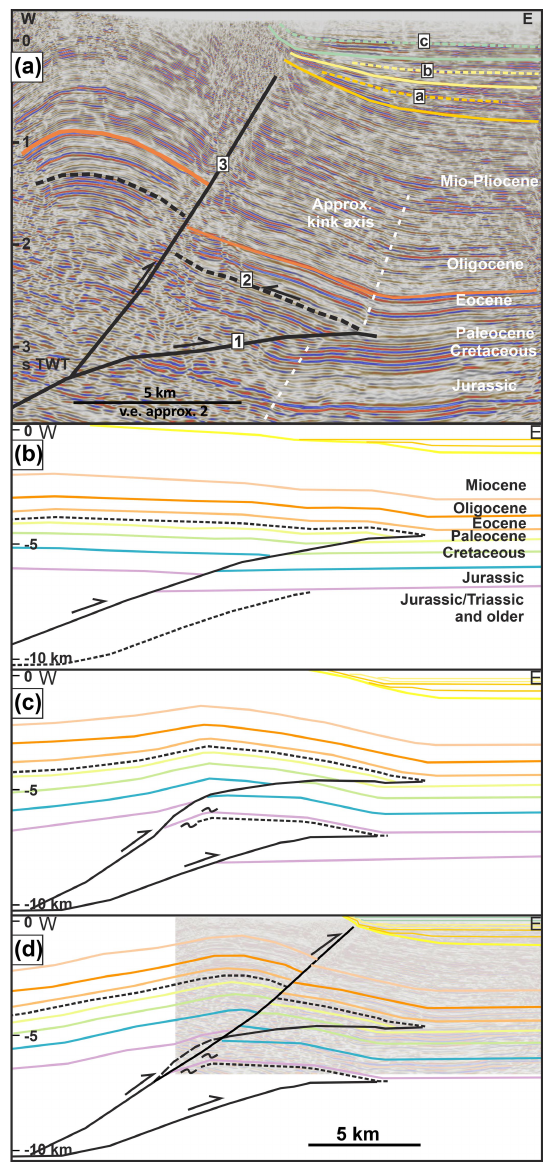
Figure 10. (a) 2-D seismic section in time domain in the northern sector (exact position not shown for confidentiality reasons) with fault and growth strata interpretation. (b) – (d) A possible solution for the growth strata pattern as discussed in the text. The seismic image in the background of panel (d) is a roughly depth-converted version of panel (a)